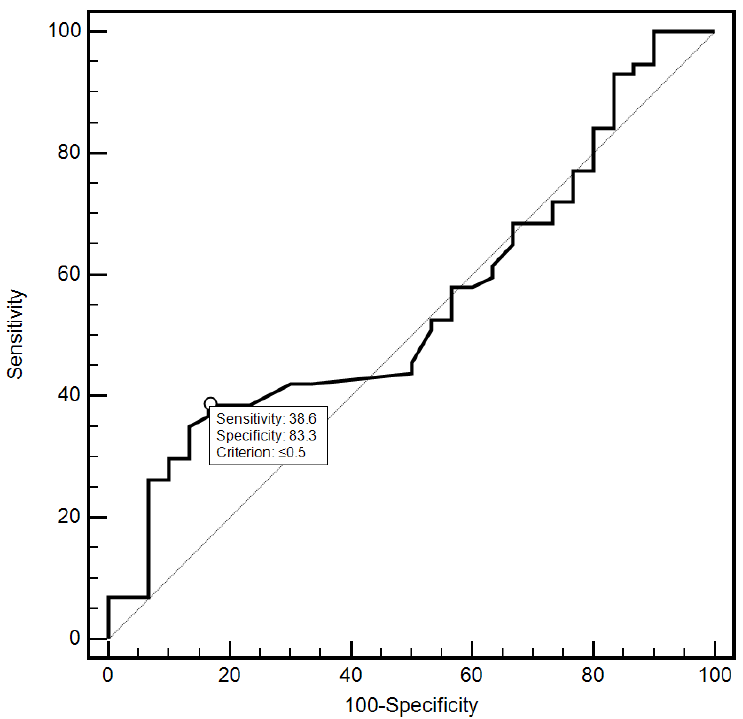
Figure 9. Diagnostic usefulness of the SR parameter—comparative tissue measurement in the early detection of preterm labor using the ROC curve.